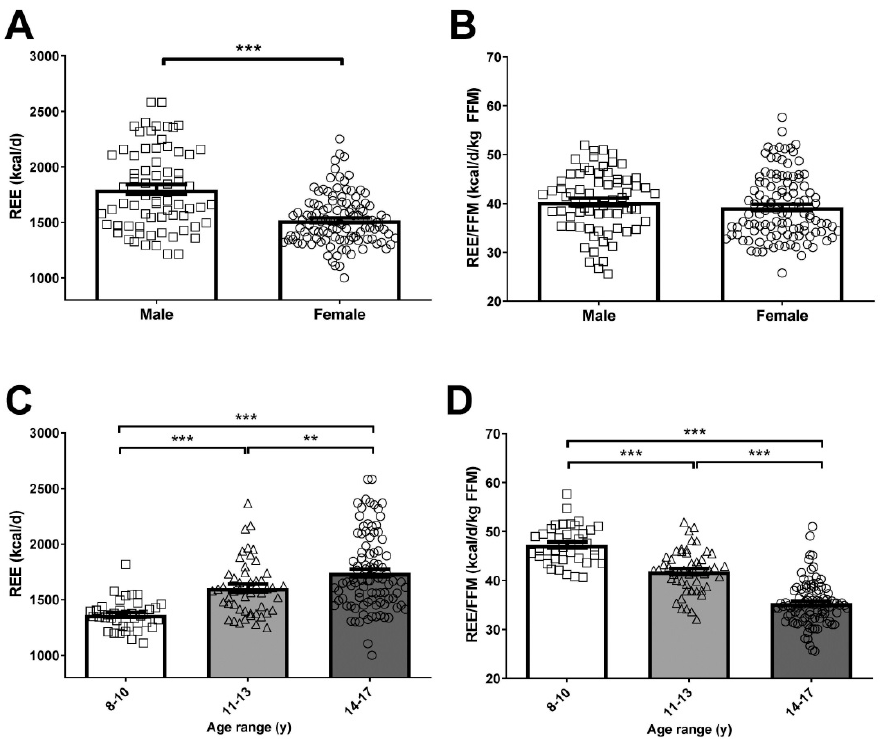
Figure 2. Comparison of absolute REE ( A , C ) and normalized by FFM ( B , D ) between male and female children and adolescents ( A , B ) or between different age groups (8–10, 11–13 and 14–17 years) ( C , D ). Values are means ± SEM. Statistical differences between groups were analyzed by ANOVA followed by LSD tests. ** p < 0.01 and *** p < 0.001 between groups. REE, resting energy expenditure; FFM, fat-free mass.